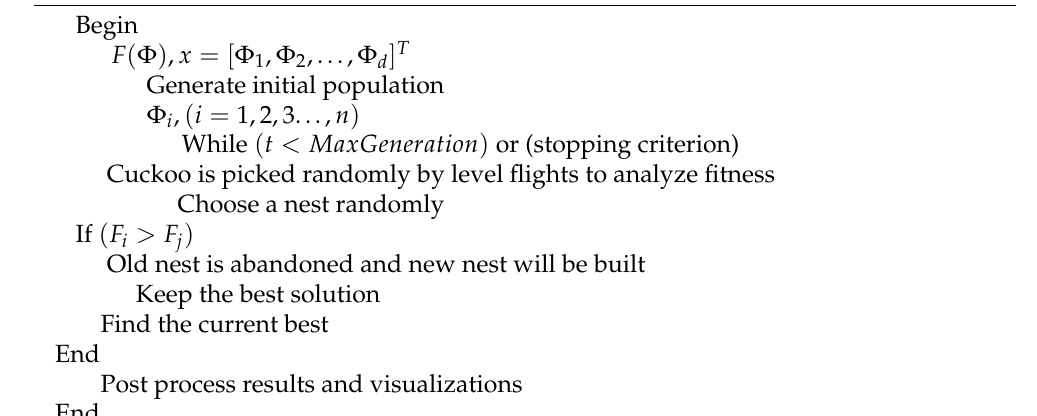
Algorithm 1 Pseudocode: cuckoo search